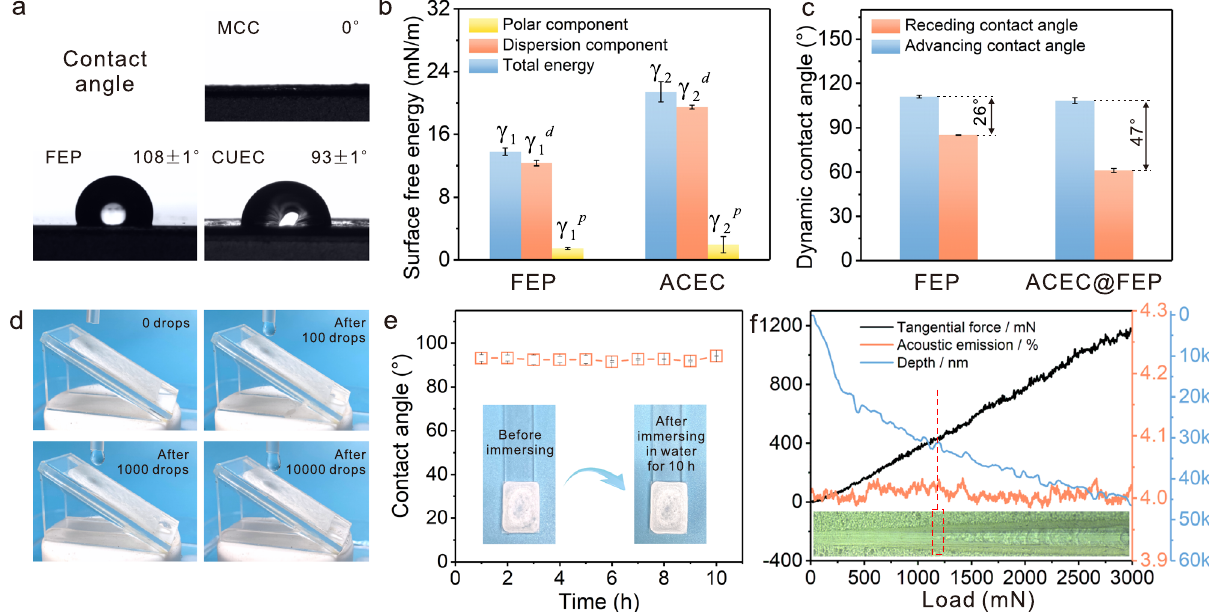
Fig. 3 Wettability and robustness. a Photographs of contact angle of MCC, ACEC, and FEP. b Surface free energy of FEP and ACEC. c Advancing and receding contact angles of FEP and ACEC@FEP. d Photographs of ACEC@FEP surface after the water droplets sliding down. e Contact angle and photographs after immersion in water for a different time. f Adhesion strength between ACEC and FEP.